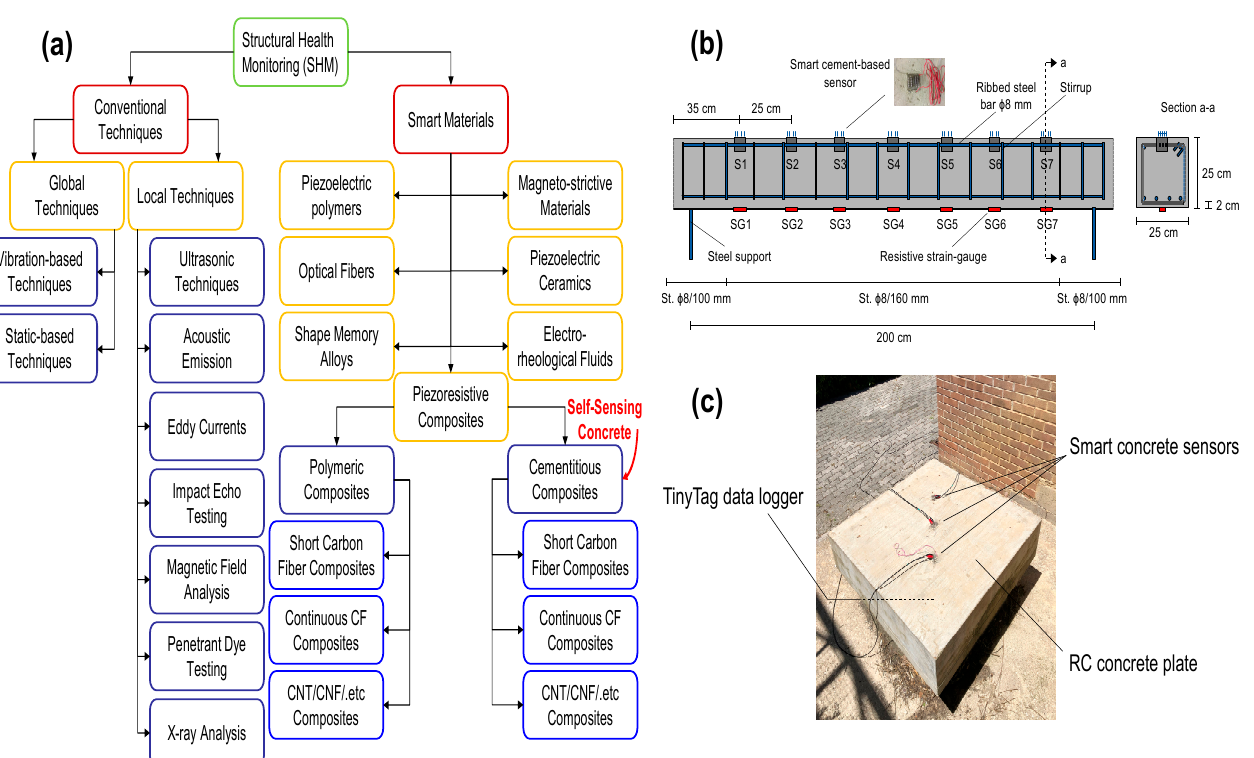
Figure 1. ( a ) Structural health monitoring (SHM) directions; ( b ) Cement-based sensors embedded in RC beams; ( c ) Cement-based sensors embedded in RC plates [13].